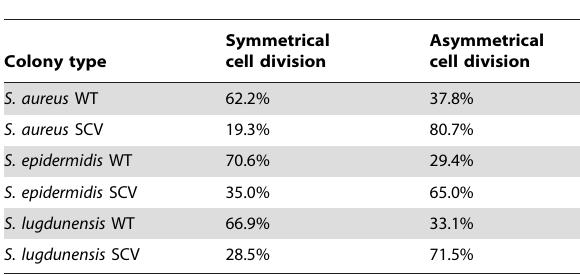
Table 1. Analysis of the incidence of apparent ‘‘symmetrical’’ vs. ‘‘asymmetrical’’ cell divisions in WT vs. SCV cells from TEM cell preparations of S. aureus , S. epidermidis and S. lugdunensis